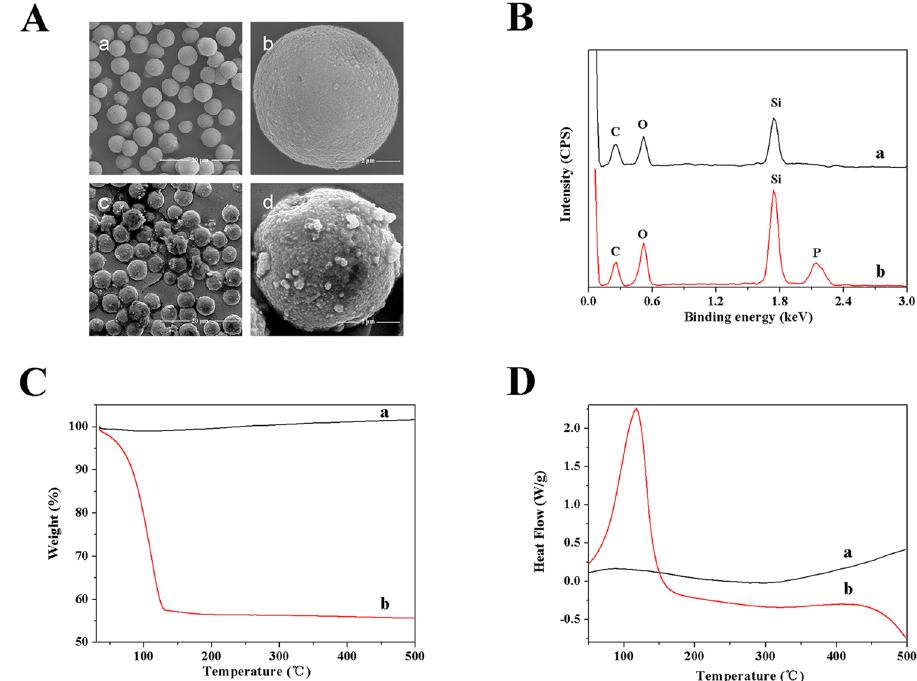
Figure 2. Characterizations of ( A ) SEM images of NCSPs (a and b) and CMCSPs (c and d); ( B ) EDS curves of NCSPs (a) and CMCSPs (b); ( C ) TGA images of NCSPs (a) and CMCSPs (b); ( D ) DSC results of NCSPs (a) and CMCSPs